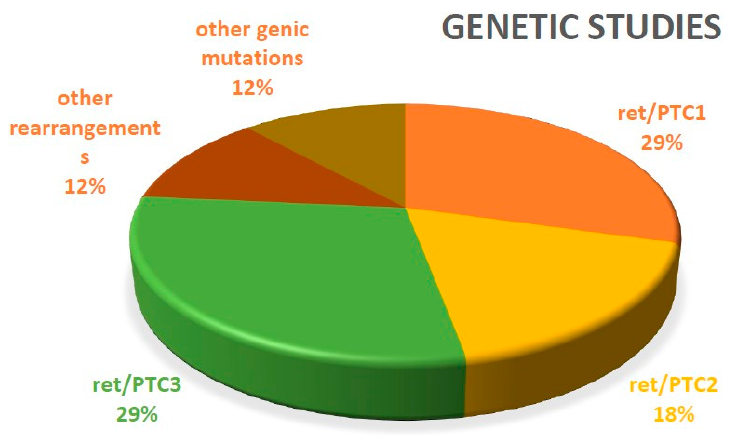
Figure 4. Genic Figure 4. Genic rearrangements.